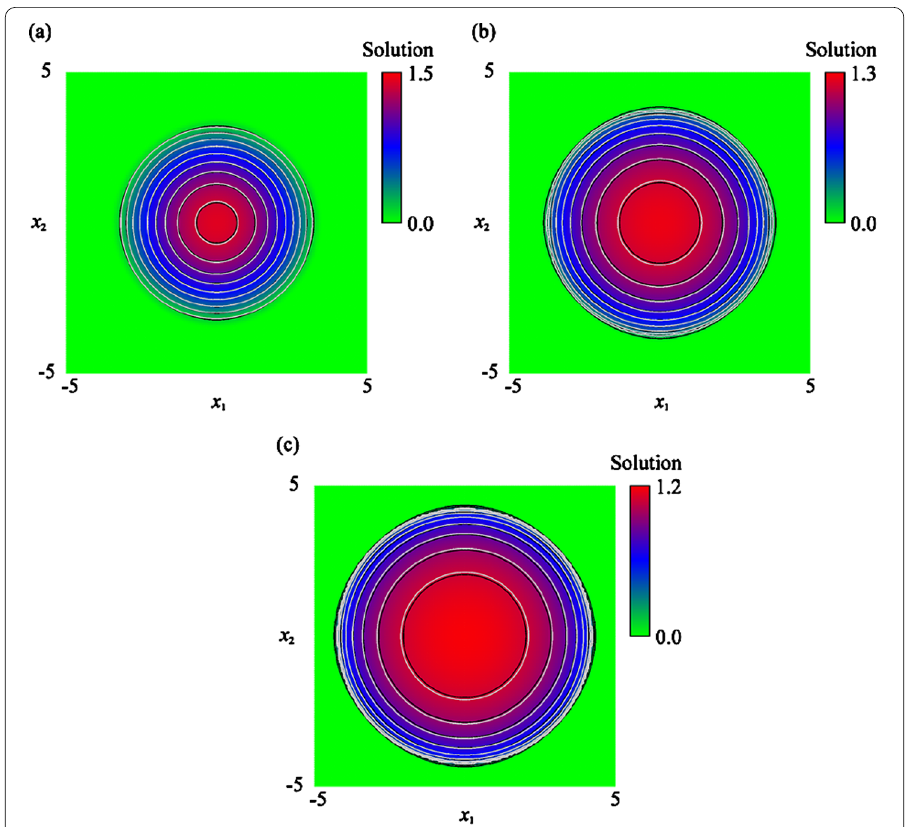
Figure 4 Comparisons of the numerical and exact solutions for Test 1. The computational results with (a) m = 2, (b) m = 3, and (c) m = 4. The contour lines for u = 0.1 n where n represent non-negative integers are depicted: black lines are for numerical solution and grey lines for exact solutions.